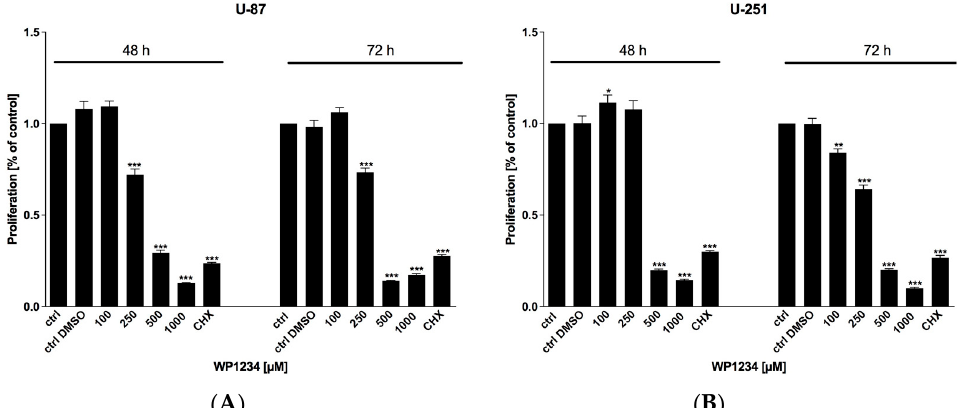
Figure 3. BrdU analysis of ( A ) U-87 and ( B ) U-251 cells’ proliferation after 48 and 72 h treatment with various concentrations of WP1234 (100–1000 μ M). As a reference cytotoxic agent, CHX (20 μ M) was used. Significant differences between the treatment and control (untreated cells) means are indicated by * p < 0.05, ** p < 0.01, *** p < 0.001.